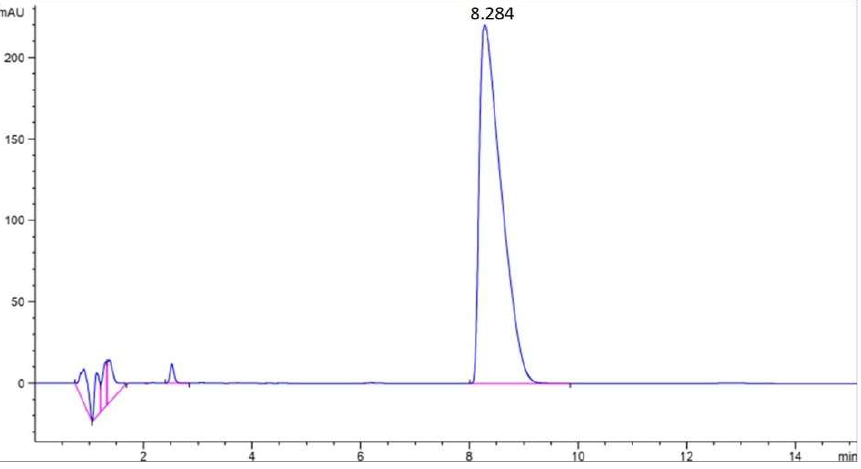
Figure 3. Chromatographic curve of the clomipramine-loaded protein aerogel.